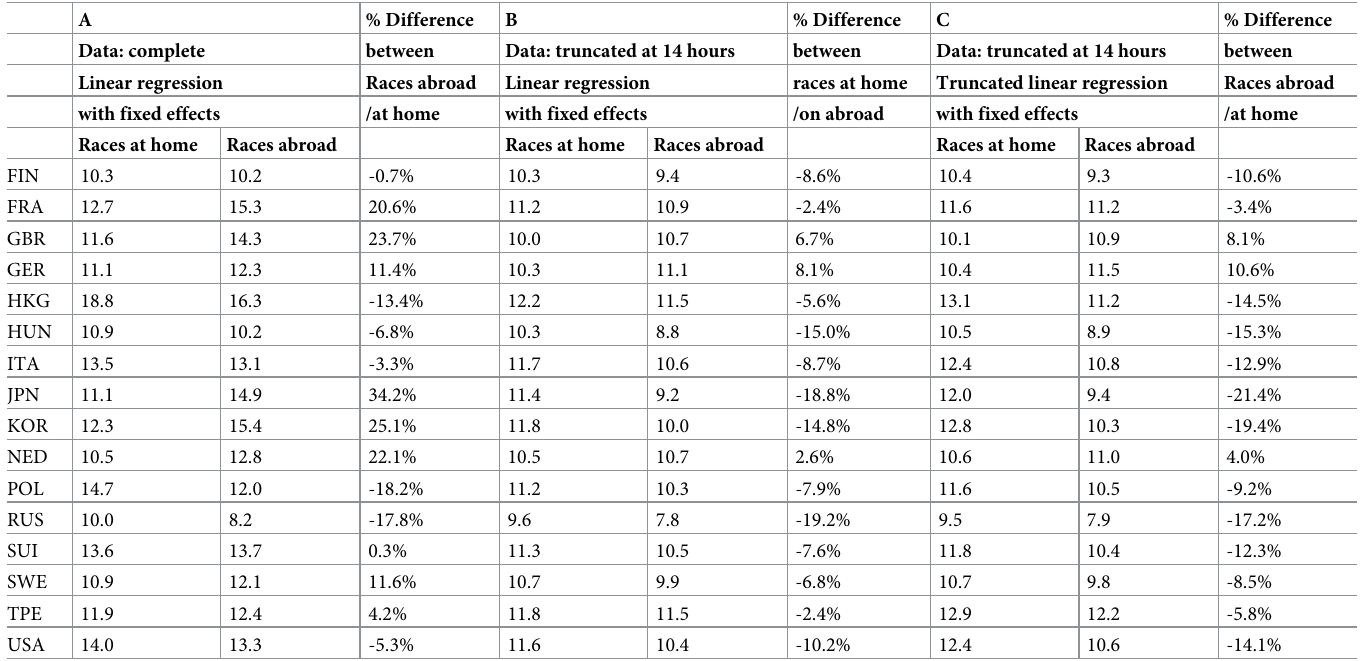
S2 Fig. Histograms, density plots and normal distributions based on mean and